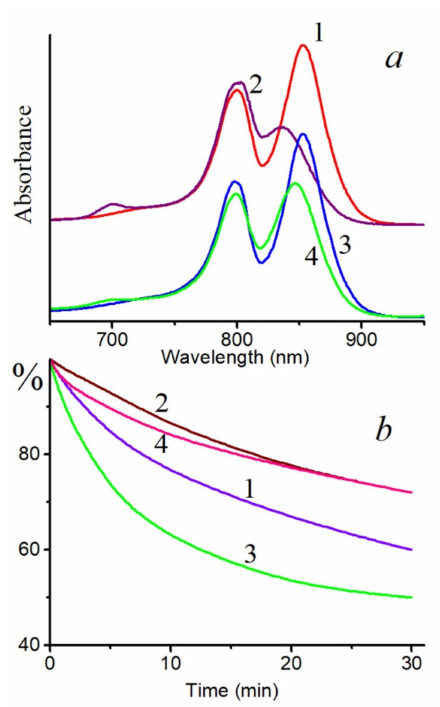
Figure 1. ( a ), Absorption spectra of control (1, 2) and diphenylamine (DPA) (3, 4) LH2 complexes of Alc . vinosum before (1, 3) and after illumination for 30 min in the presence of 50 µ M RB (2, 4); ( b ), bleaching curves of BChl850 in the control (1, 3) and DPA (2, 4) complex LH2 from Alc. vinosum in the presence of 50 µ M RB (1, 3) and under illumination with blue light (2, 4).